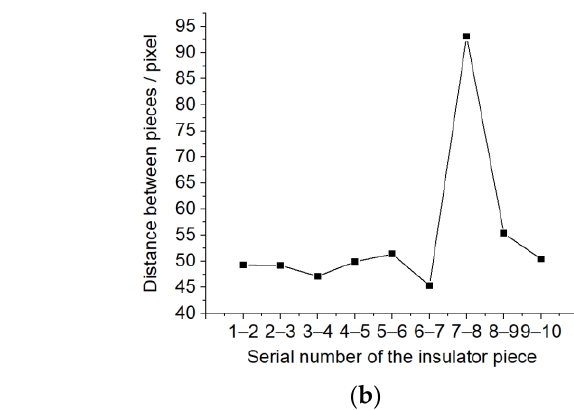
Figure 15. Some test images and contour extraction results. ( a ) Similarity standard deviation and similarity value between pieces of damaged insulator shown in Figure 14; ( b ) Distance between pieces of damaged insulator shown in Figure 14.